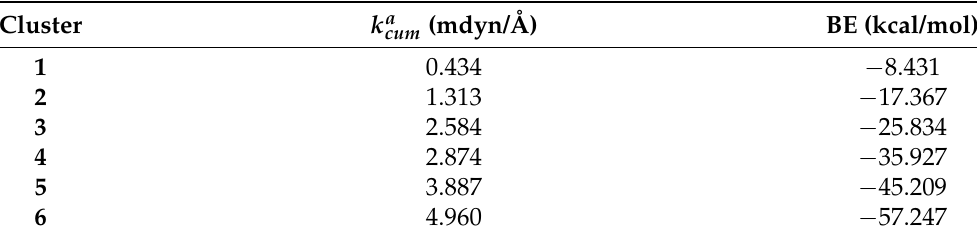
Table 4. The cumulative local mode force constants k a cum and binding energies (BE) for clusters 1 – 6 at the ω B97X-D/6-311++G(d,p) level of theory using the implicit CPCM solvation model.